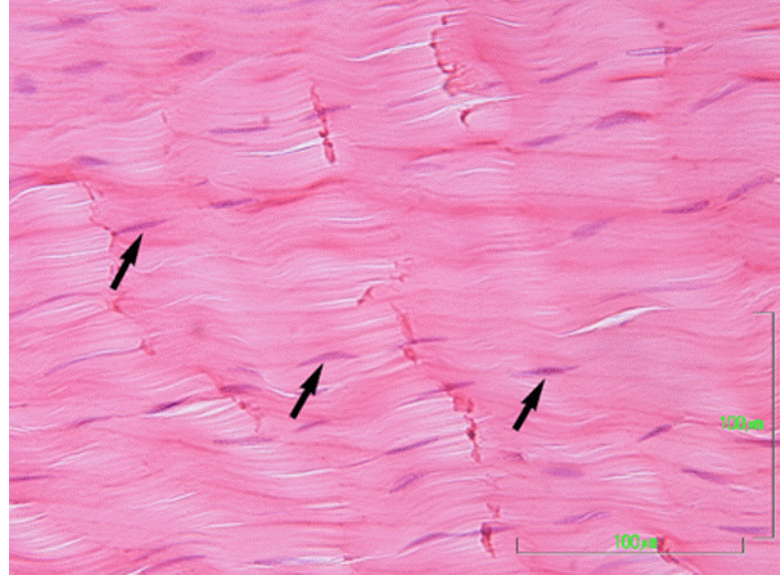
FIGURE 1. Light microscope image of longitudinally sectioned human Achilles tendon. Collagen fiber bundles appear parallel, wavyform with interposed flattened parallel fibroblasts (arrows). Bar = 100 μ